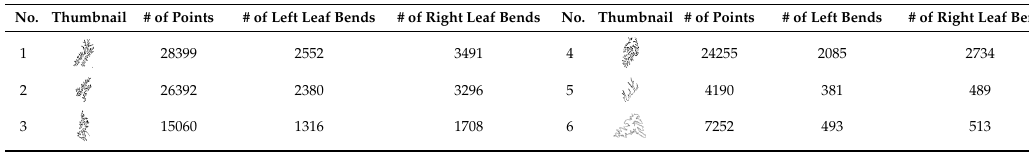
Table 2. Parameters for some of the experimental curves.